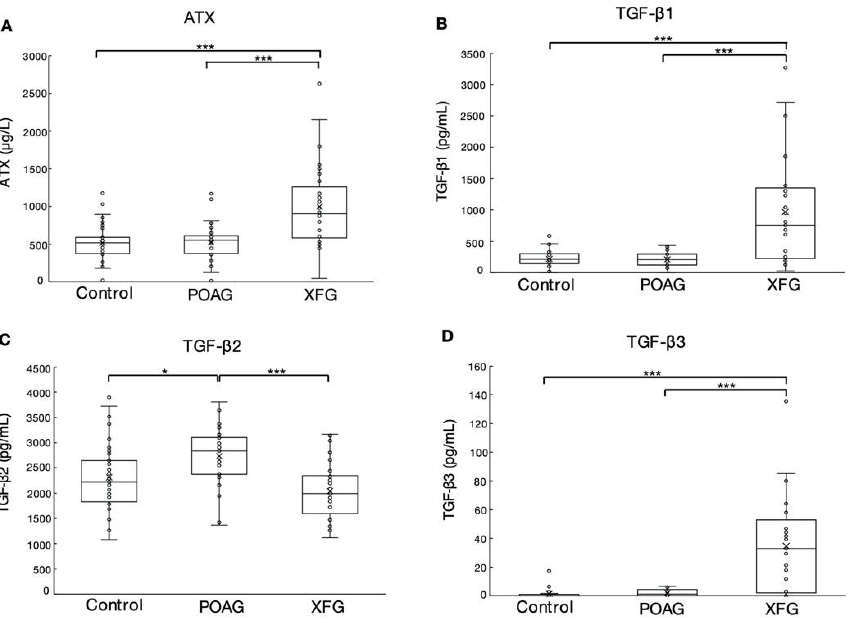
Figure 1. Levels of ATX, TGF- β 1, TGF- β 2, and TGF- β 3 in the AH. ( A ) The level of ATX, as measured by immunoenzymetric assay was significantly higher in the XFG than control and POAG groups (both p <0.001). ( B ) The level of TGF- β 1 was significantly higher in the XFG than control and POAG groups (both p <0.001). ( C ) The level of TGF- β 2 showed the inverse tendency, especially between the POAG and XFG groups ( p < 0.05 between control and POAG, p <0.001 between POAG and XFG).